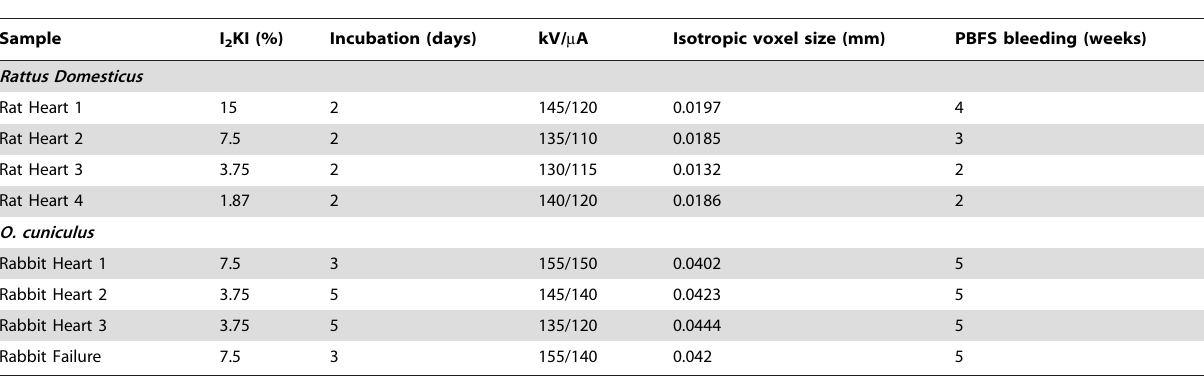
Table 1. Sample preparation and scanning